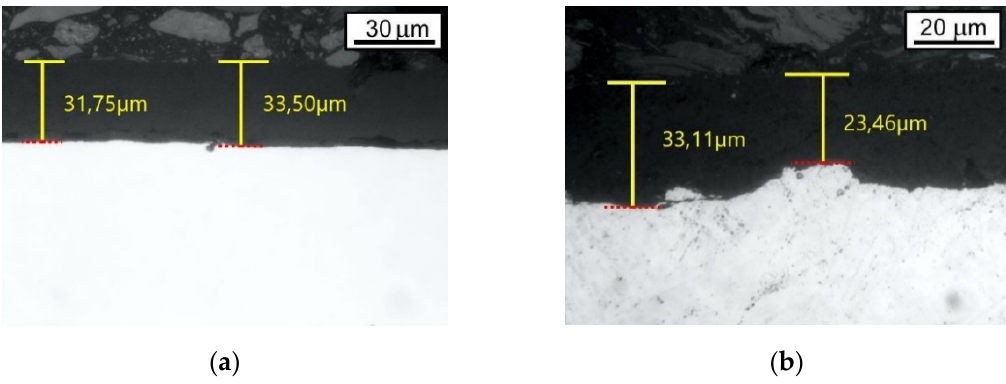
Figure 4. The microstructure of the analyzed coatings observed under the optical microscope: ( a ) Group 1, ( b ) Group 2.